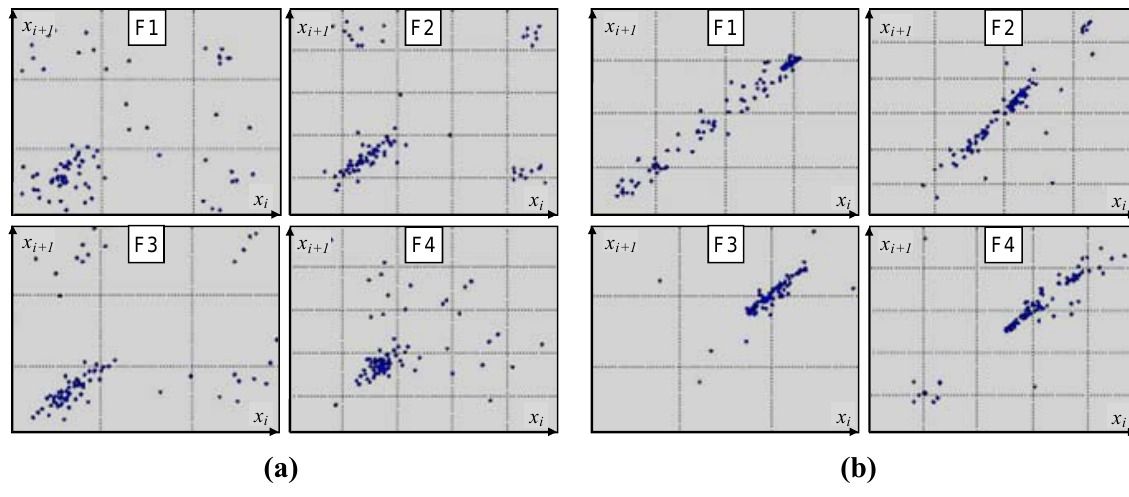
Figure 2. Poincare Maps produced for four formants (F1 through F4) extracted from a sentence uttered with the emotion ‘fear’ (a) and ‘joy’